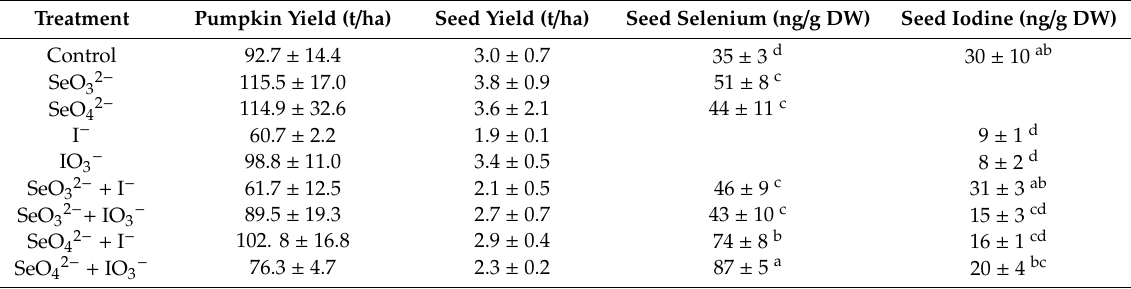
Table 2. E ff ects of the various foliar treatments on the characteristics of pumpkin yields and seed Se and I levels. Treatments were based on Se at 10 mg / L and I at 1000 mg /